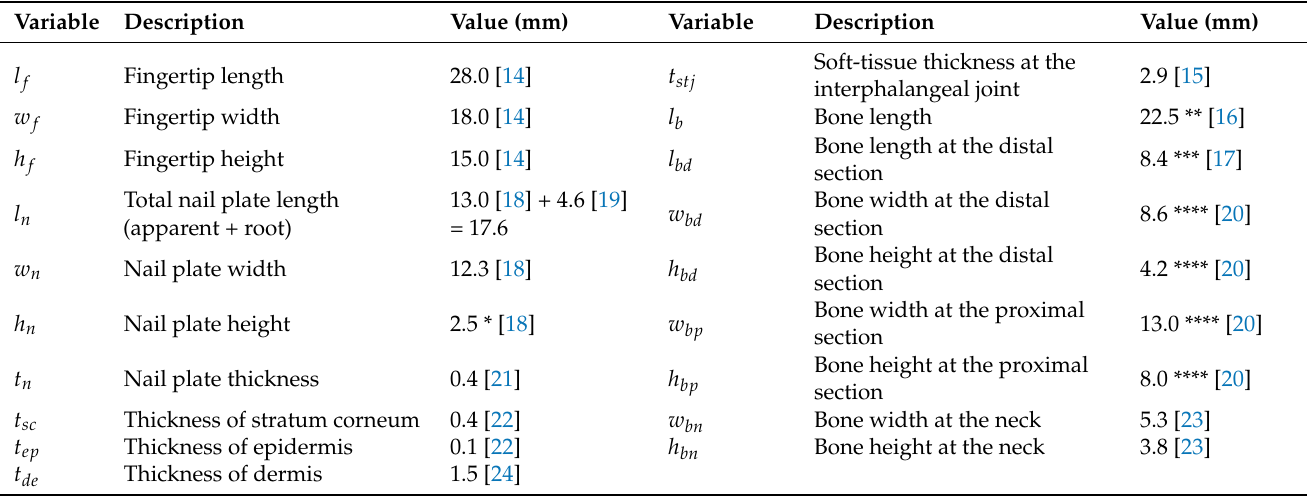
Figure 1. The variables that govern the dimensions of DigiTip: ( a ) Exterior fingertip dimensions; ( b ) thicknesses of tissue layers; ( c ) dimensions of the distal phalanx. Table 1. The descriptions and values of the model dimensions shown in Figure 1. The selected values are given along with the references from which they were taken.